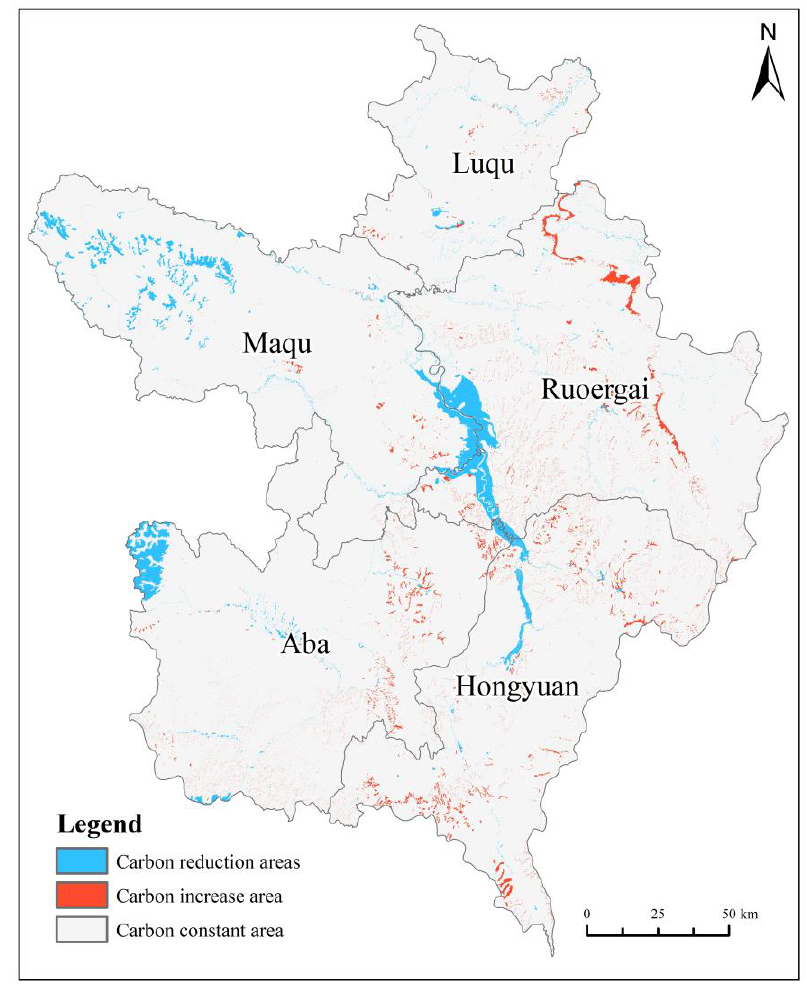
Figure 6. Changes in the spatial distribution of carbon stocks in the Ruoerge alpine grassland region during the period 2000–2020.